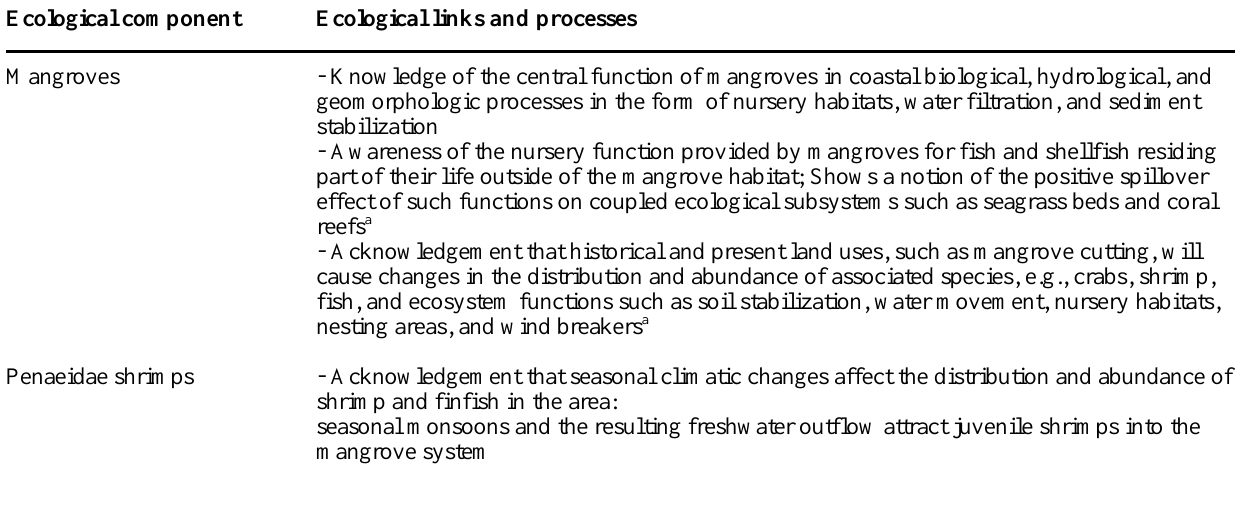
Table 6. Summary of local ecological knowledge common to all studied occupational groups in the target community,